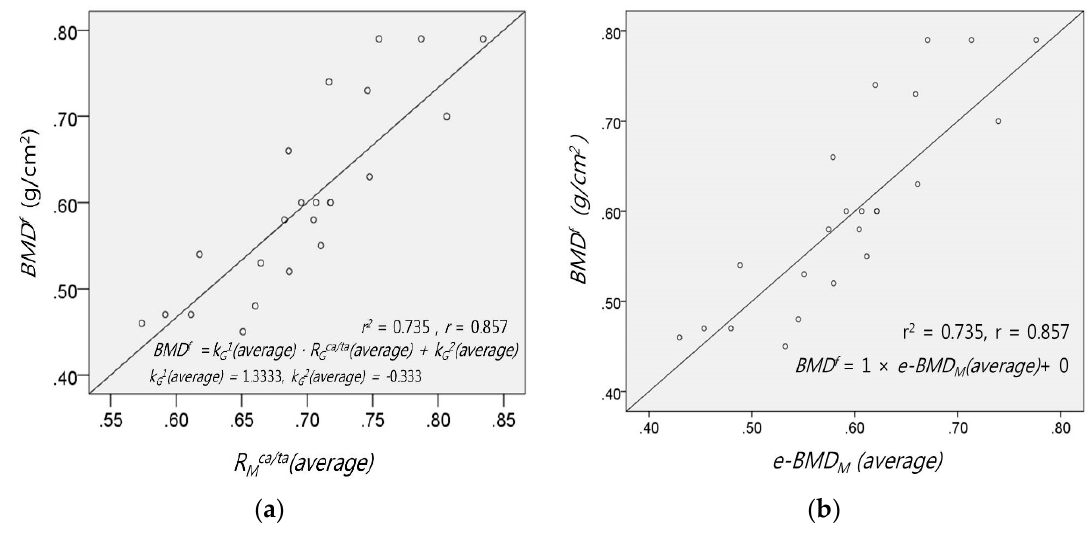
Figure 5. ( a ) Regression plot of R Mca / ta ( average ) versus BMD f . ( b ) Correlation plot of e ‐ BMD M versus BMD f .